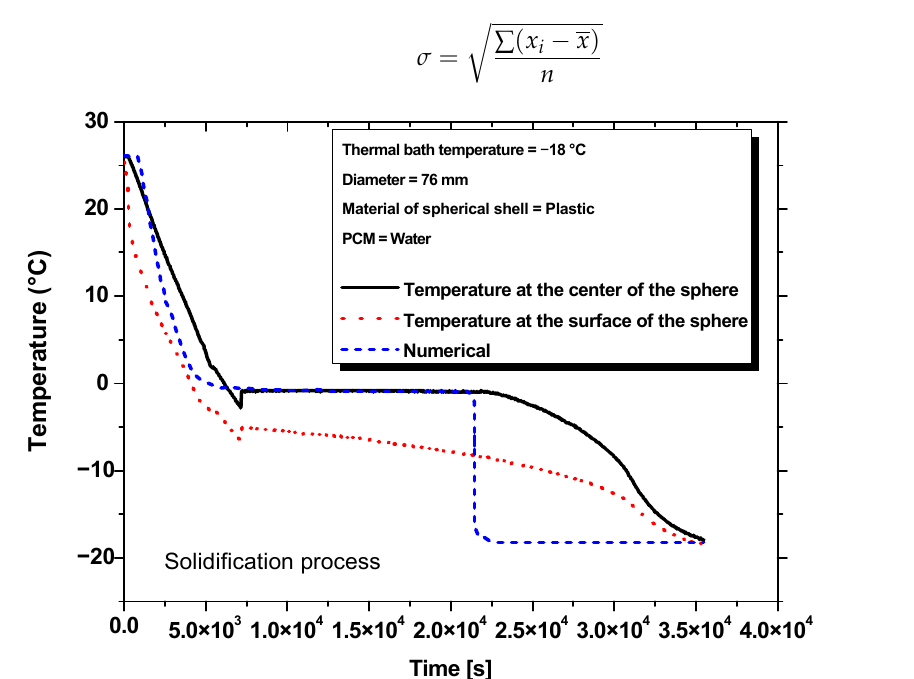
Figure 5. Numerical and experimental temperature change in the solidification process of the 76 mm diameter plastic spherical capsule.